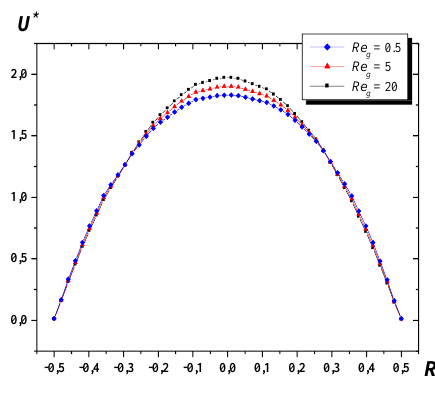
Fig. 4. Axial velocity vs. pipe radius at X * =